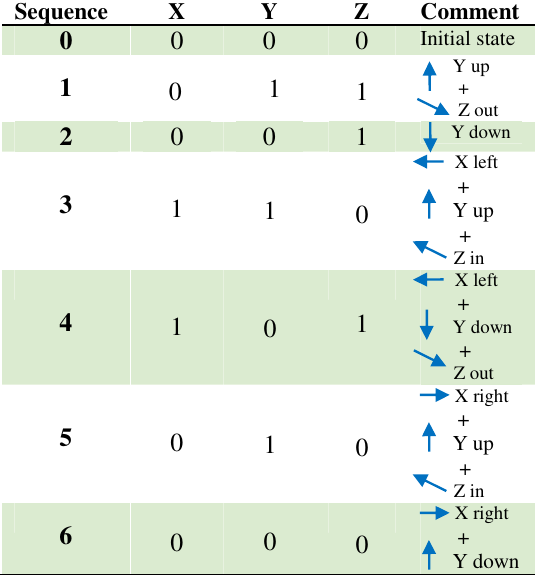
Enhanced sequence for the third obstacle.